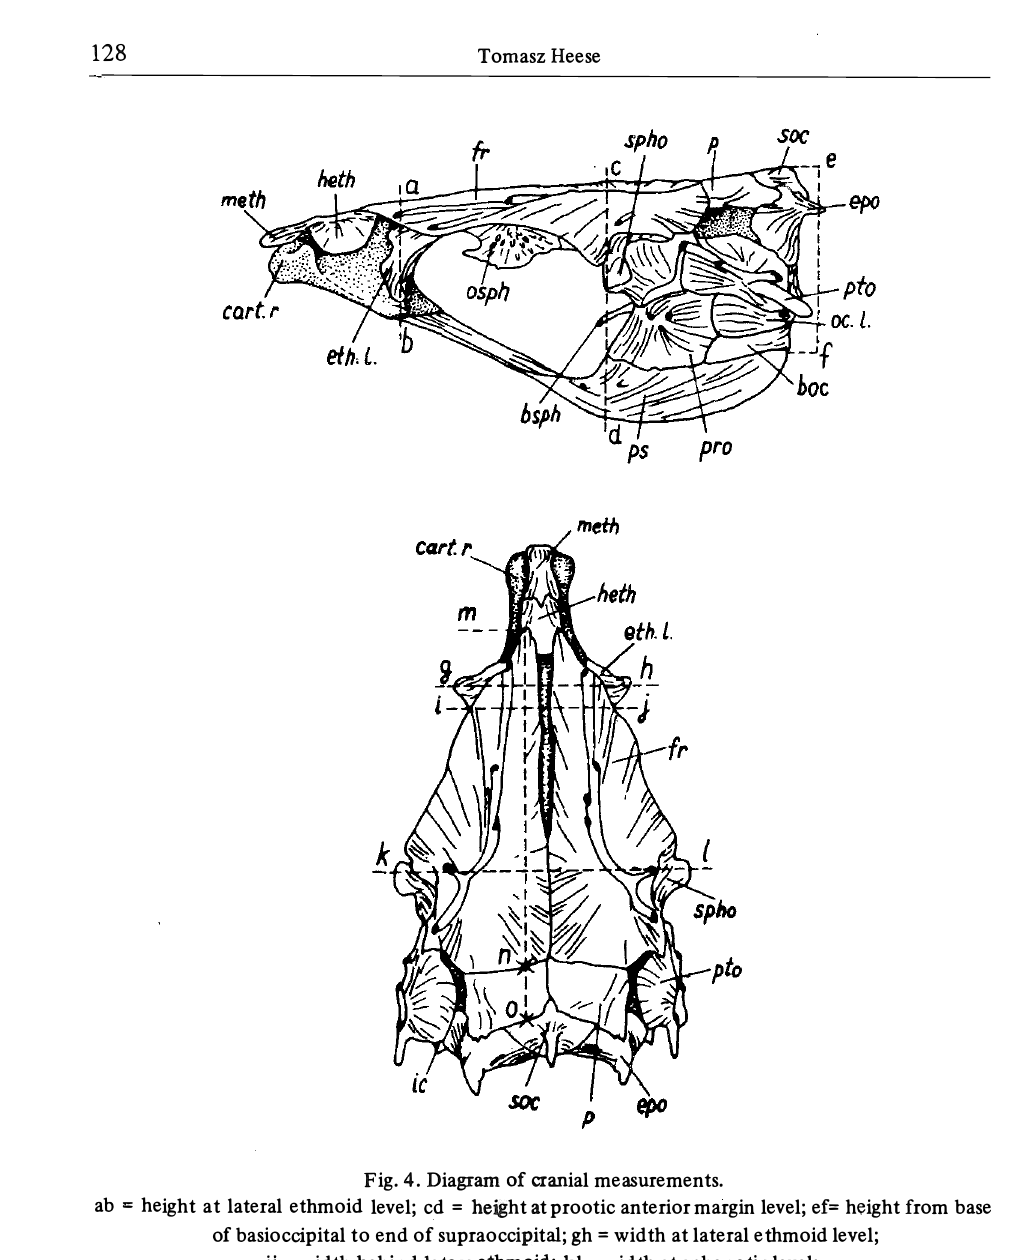
Fig. 4. Diagram of cranial measurements. ab = height at lateral ethmoid level; cd = height at prootic anterior margin level; ef= height from base of basioccipital to end of supraoccipital; gh = width at lateral e thmoid level; ij = width behind latera ethmoid; kl = width at sphenotic level; mn = leng th of fro nt al; n o = l en g th of p ar i e t a l . Cranial bones deno ted as: boc = basio ccipital; bsph = ba siph enoi d; car t.r. = r o st r a l c a r ti l a g e ; e p o = ep ioti c; e th . l . = la te ra l etm oid; fr = fro nta l; h eth = hype thmoid; ic = i n t e rc a l ar ; meth = m e se t h m o id ; o c . l . = l a t e ra l o c c i p it a l ; o sp h = or bitos p h e n o i d; p = p ar i e t a l ; pr o = pr ooti c; p s = p a r a s p h e n o i d ; p to = p t e r o tic ; s o c = s u p r a o c c i p i t a l ; s ph o = s p h en o ti